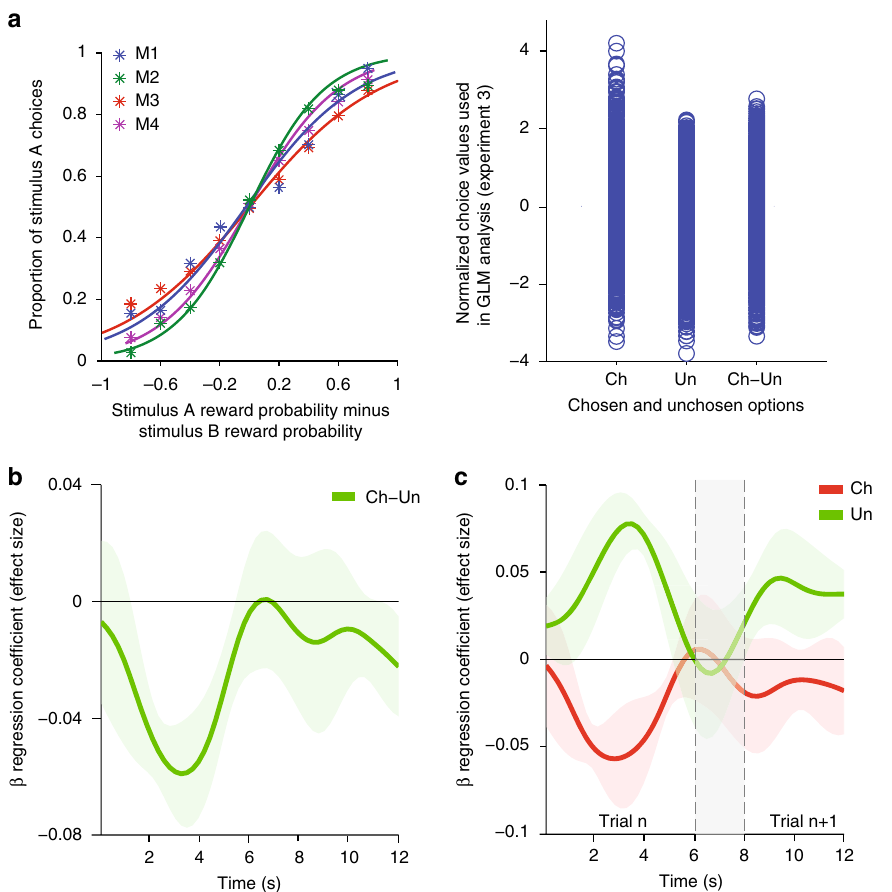
Fig. 5 VmPFC activity — experiment 3. In experiment 3, each of the three options was associated with a drifting probability of reward. a Left panel: sigmoid functions illustrating the proportion of trials on which a stimulus (stimulus A) was chosen as a function of the difference between the values estimated for that stimulus and the alternative option (stimulus B). The value estimates were derived from a standard reinforcement learning algorithm (METHODS: Reinforcement learning — experiment 3). a Right panel: normalized choice values used in the GLM analysis. As in Fig. 3c (right panel) normalization was carried out separately on the chosen option value estimates, unchosen option value estimates, and the chosen – -unchosen value difference estimates. The effect shown in b is unpacked in c , demonstrating that activity in macaque vmPFC decreases as the value of the chosen option increases and increases as the value of the unchosen option increases. Note that in experiment 3 trials were performed quickly so that activity in the fi rst seven seconds, approximately, re fl ects the current trial (trial n ). Later activity re fl ects decisions on subsequent trials (trial n + 1 ). The gray vertical bar indicates the approximate boundary between trial n and n + 1 . On 66% of occasions the option chosen on trial n would be offered again on trial n + 1 (and it was often chosen again) and on 66% of occasions the unchosen option on trial n would be offered again (in which case it was frequently unchosen again) and so the contrasts for trial n capture activity also on trial n +